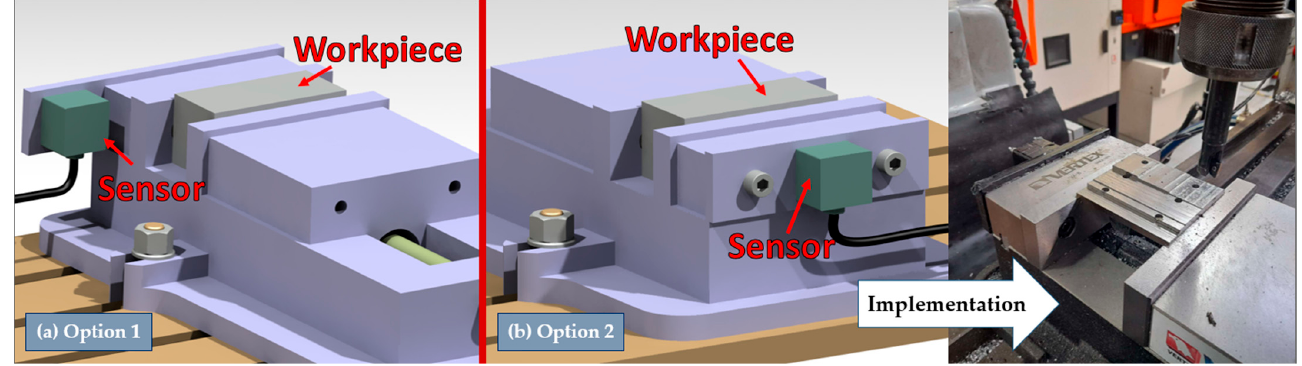
Figure 1. Sensor integration with a modified steady jaw – Option 1 ( left ); sensor integration on the back of the vice – Option 2 ( right ).